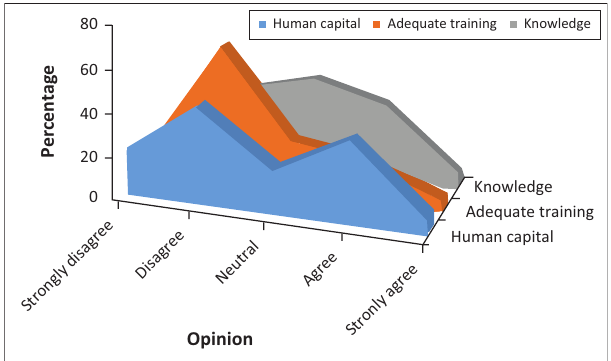
FIGURE 4: Human resource